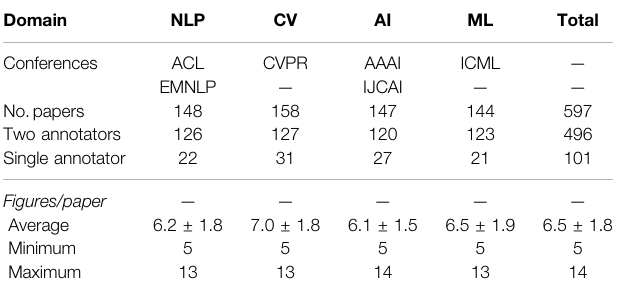
TABLE 1 | Statistics ofournewly proposed data setfor central fi gure identi fi cation in computer science. Domain